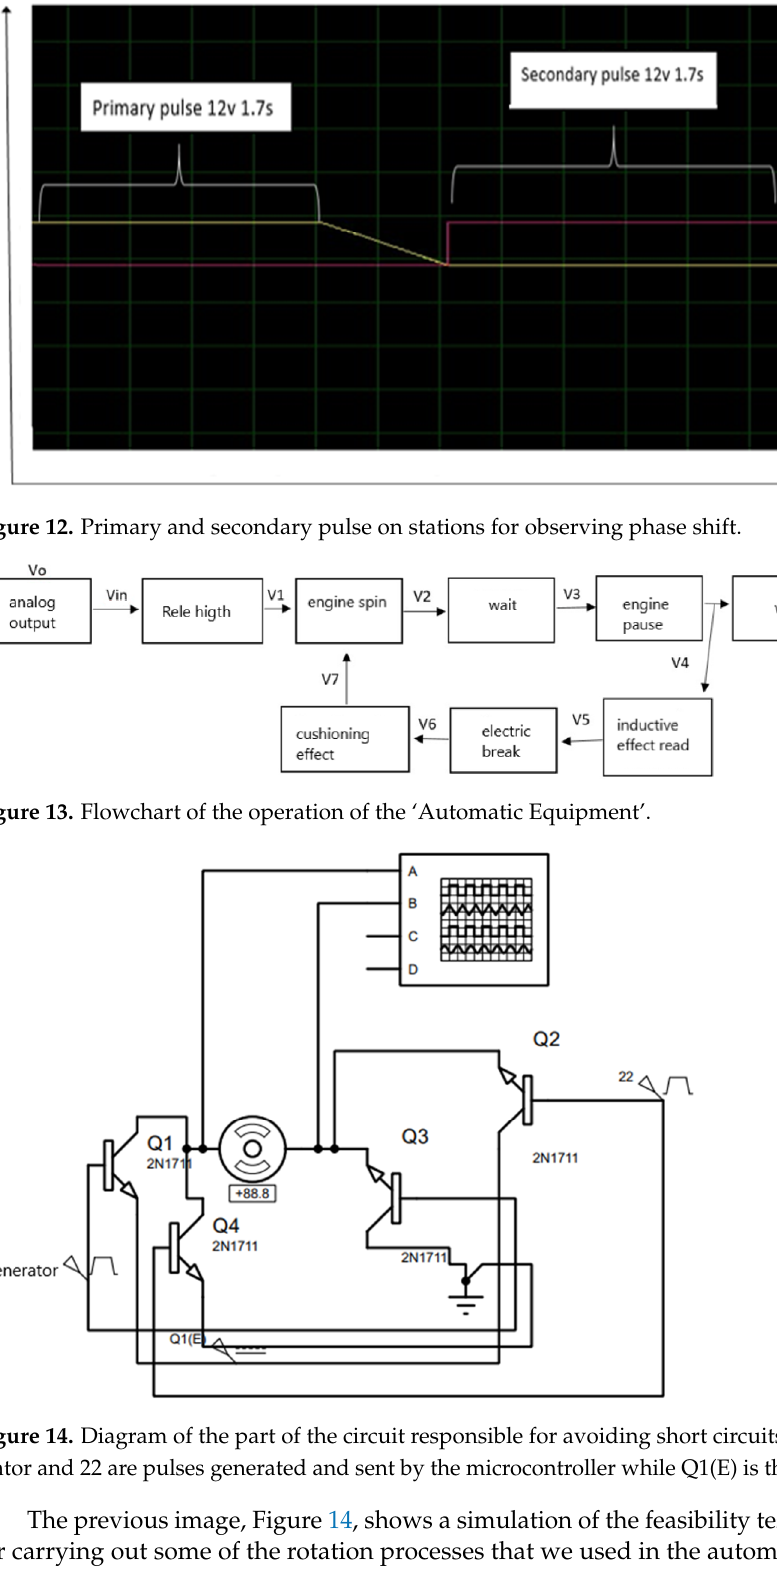
Figure 11. Test reading for electric brake pulse on a 12 v scale per square and 2 s.